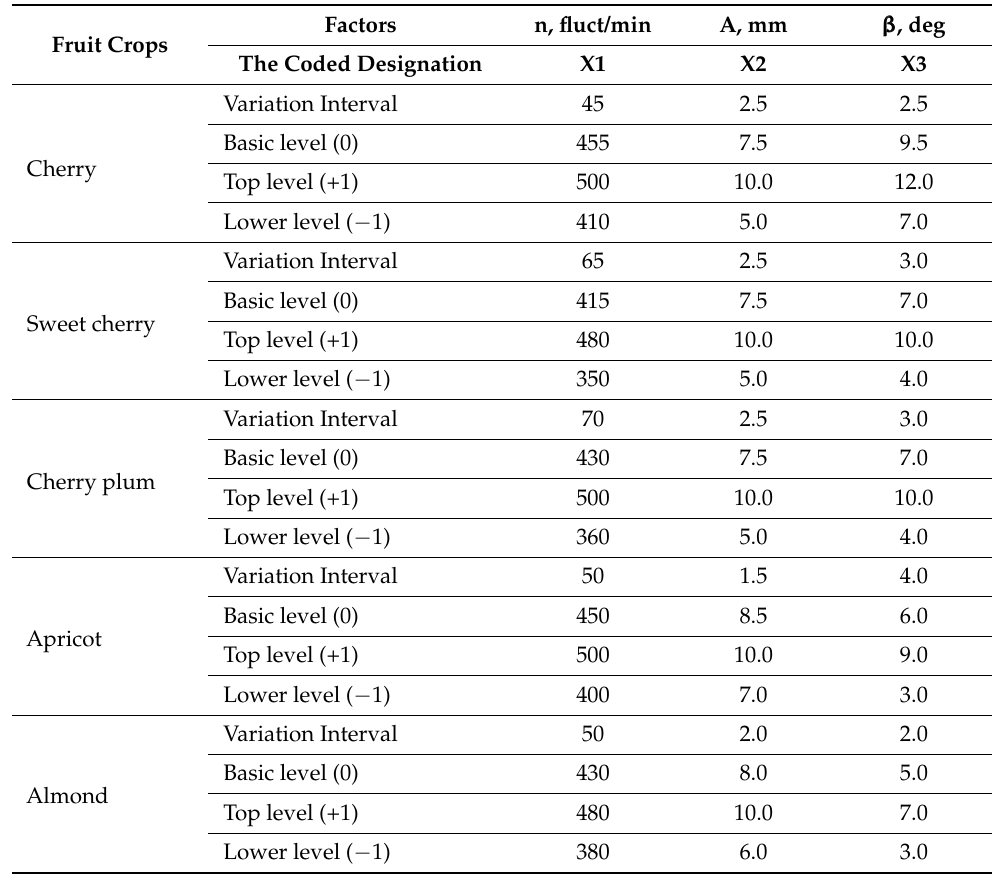
Table 2. Factors variation